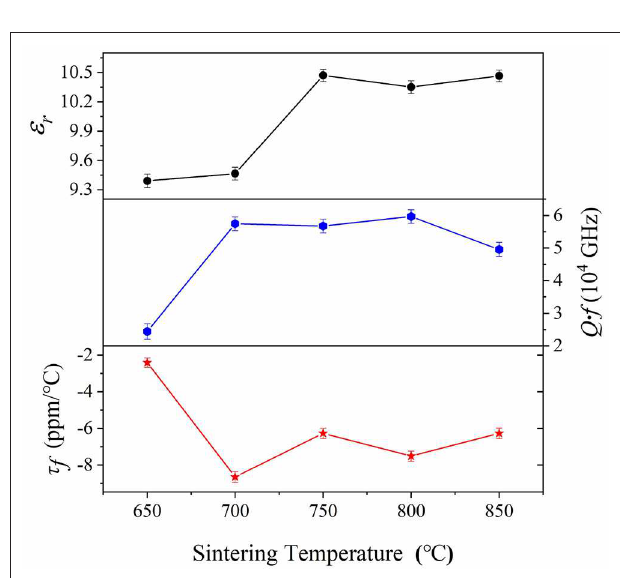
FIGURE 6 | Curves of microwave dielectric properties as a function of sintering temperature for Ce 2 (Zr 0.94 Sn 0.06 ) 3 (MoO 4 ) 9 ceramics in the temperature range from 650 to 850 ◦